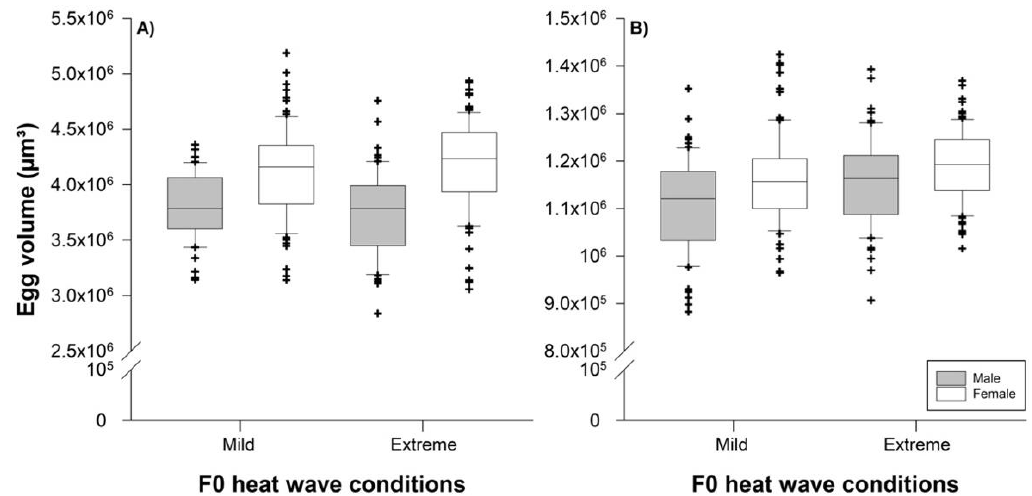
Figure 3. Effects of the parental (F0) heat wave conditions (reared under mild or extreme waves during juvenile development) on offspring male (grey boxes) and female (white boxes) egg volumes of P. persimilis ( A ) and T. urticae ( B ). The horizontal centerlines in each box represent the median, the box limits represent the interquartile (IQ) range from the 25th to 75th percentiles, the whiskers extend the IQ range to 1.5 times and outliers are depicted as symbols.